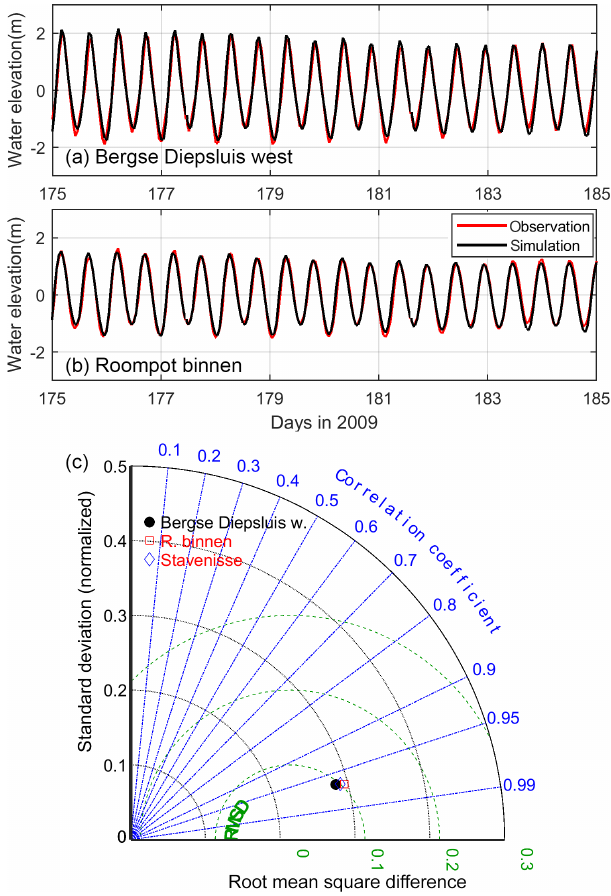
Figure 2. (a, b) Time series of modeled and observed water eleva- tion and (c) the Taylor diagram of the water elevation comparison. See Fig. 1 for the locations of data